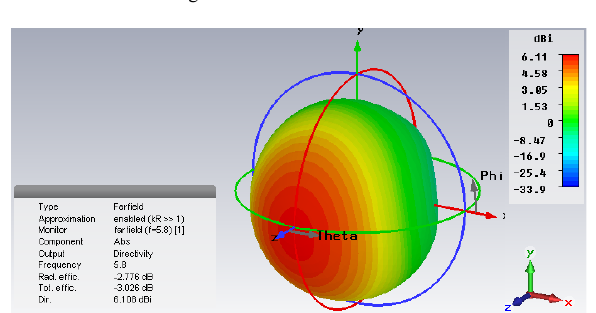
Figure 6. Return loss for RTDuroid 5880.